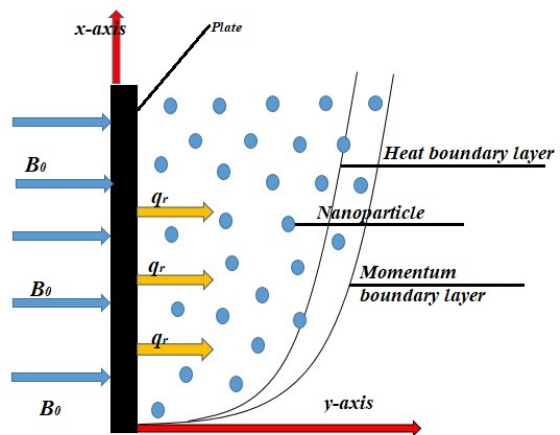
Figure 1. Geometry of the problem.